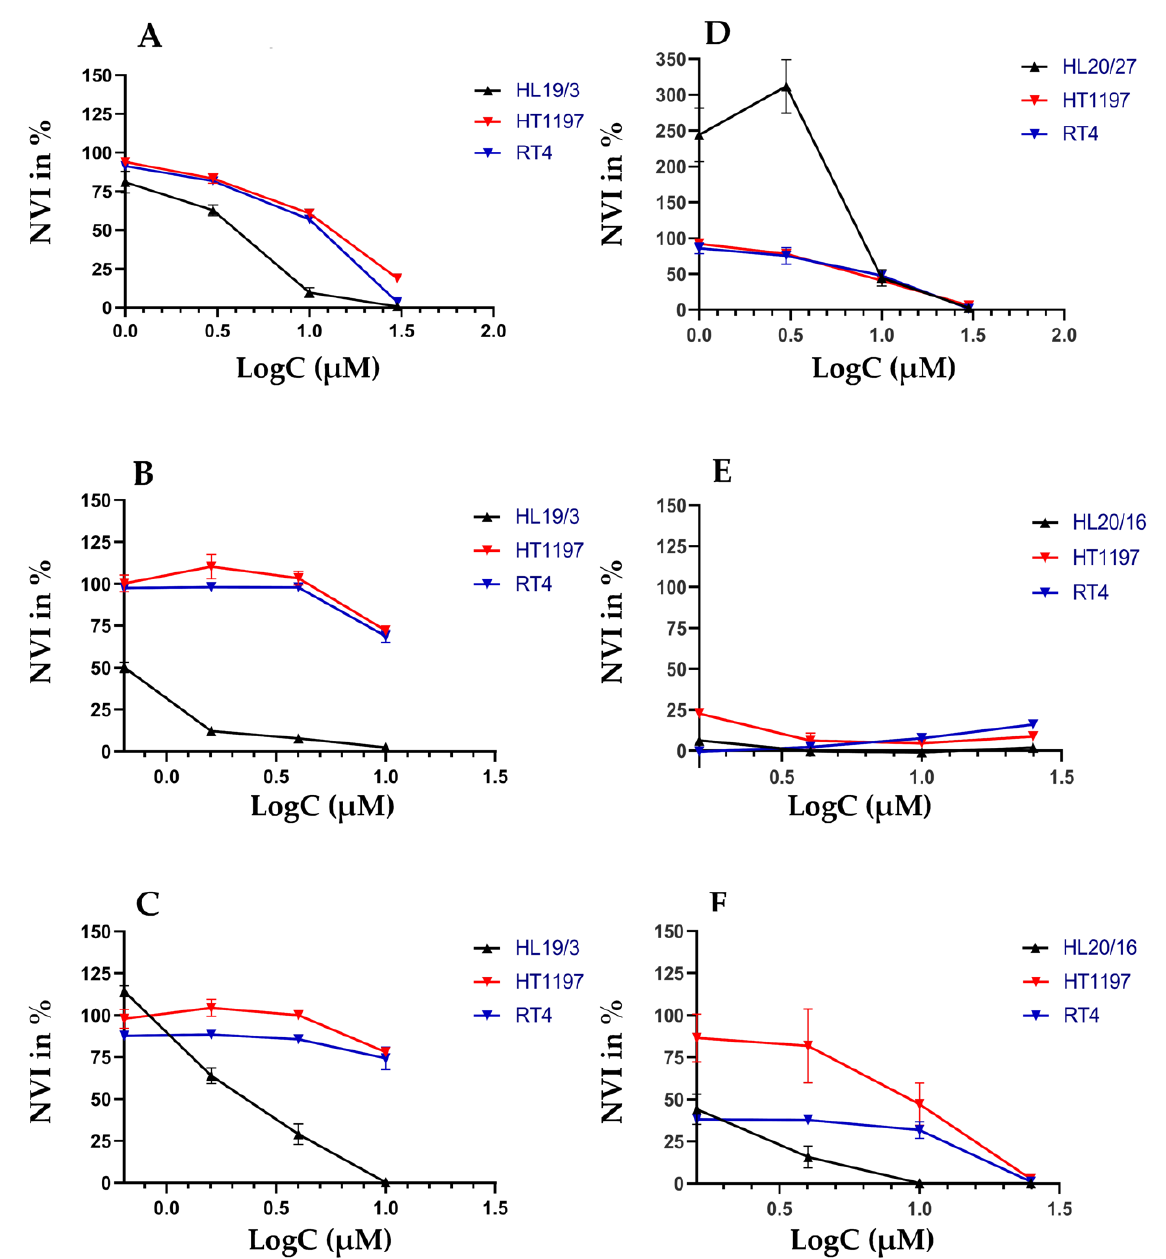
Figure 3. Comparing cytotoxic effects in urothelial cells in 2D cultures by two different assay types. Normal urothelial cells (NUCs HL19/3, HL20/16, HL20/27) as well as bladder cancer cell lines HT1197 and RT4 were incubated with different concentrations of CIS ( A , D ), VTX ( B , E ), S63 ( C , F ) to determine the cell viability after two days of incubation by either a chemiluminescence assay (CTG 2.0; A – C ) or a colorimetric assay (WST; D – F ). The mean normalized viability index in percent (NVI %; ordinate, Y-axis) is disclosed as function of the logarithm of drug concentrations employed (LogC; (µM), abscissa, X-axis).